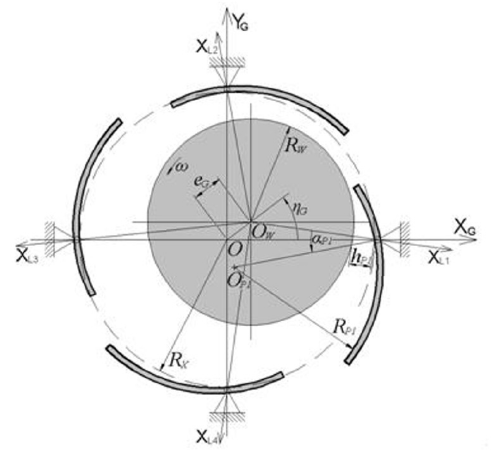
Figure 2: Tilting pad bearing